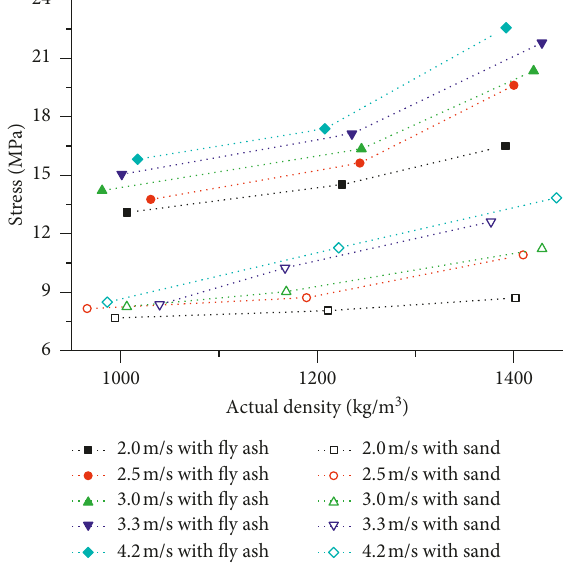
Figure 17: Relationship between the actual density and ultimate compressive strength.